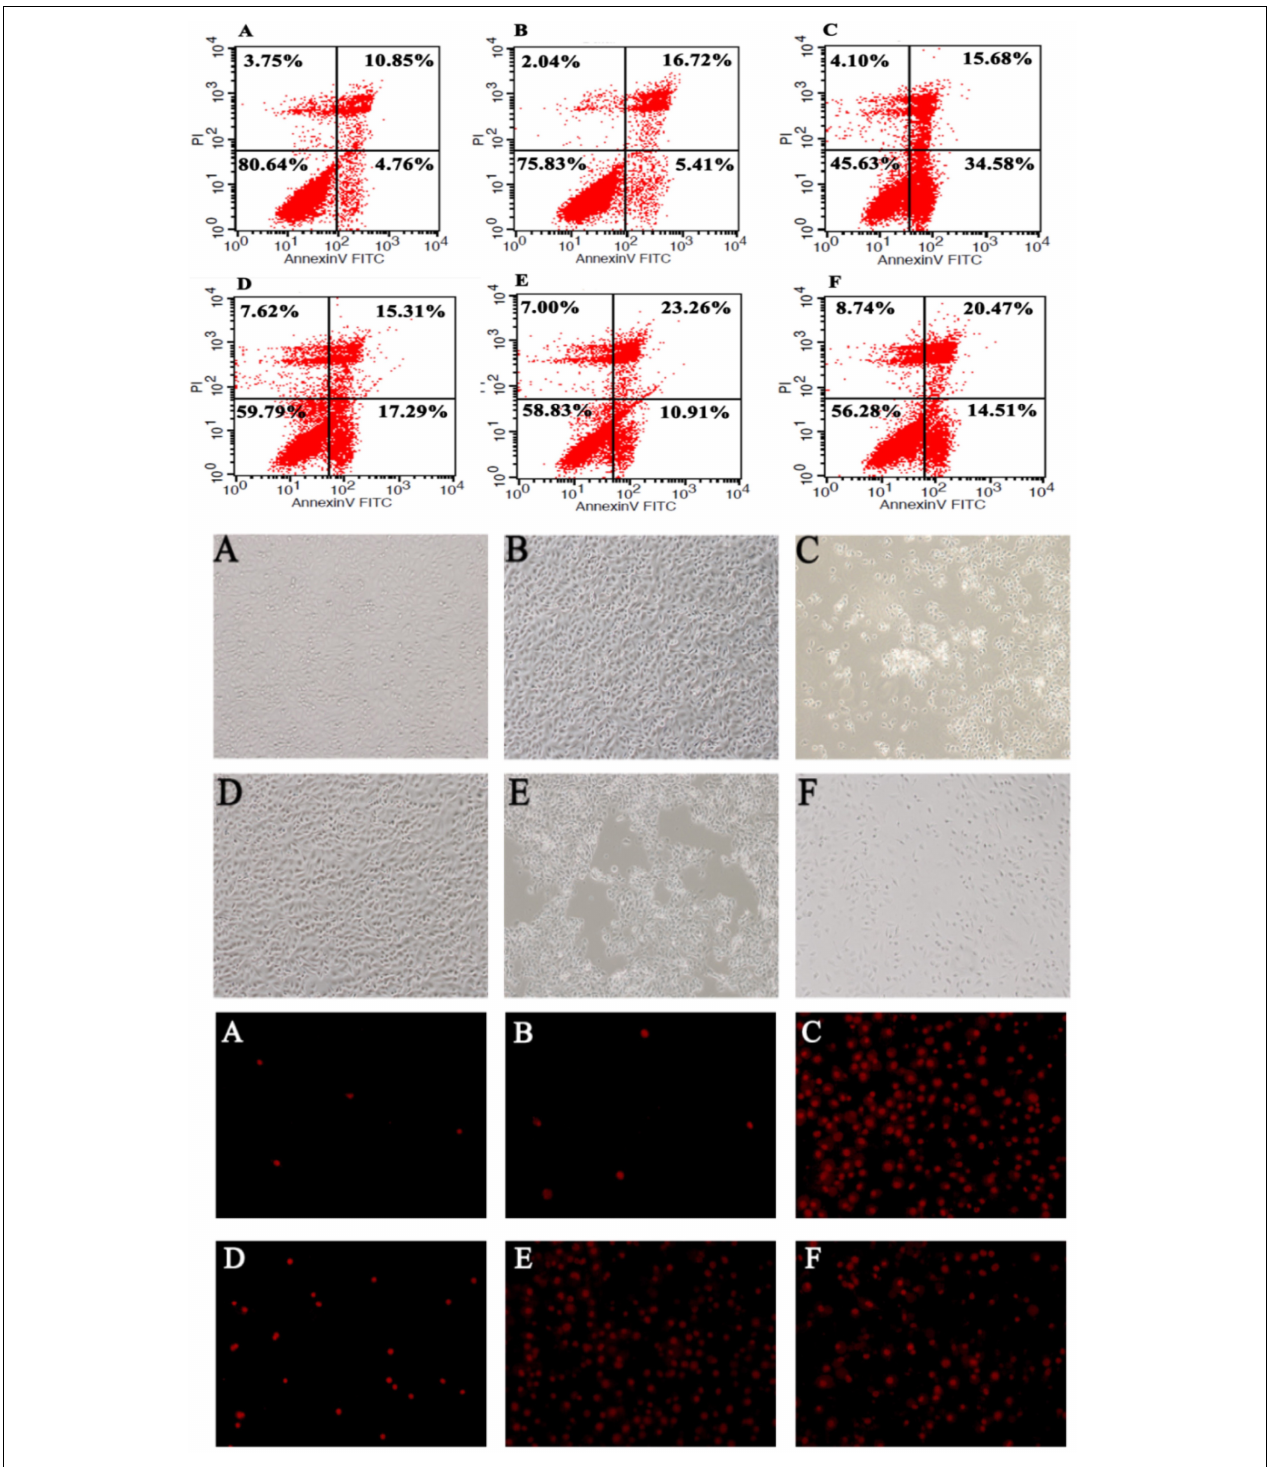
FIGURE 6 | Bacteroides fragilis ZY-312 inhibits colon cell apoptosis induced by C. difficile . Flow cytometry analyses (top) of HT-29 cells in all groups are shown. The lower right quadrant represents colon cells in early apoptosis. Microscopic observations (middle) of IEC-6 cell morphology and viability and PI staining (bottom) of IEC-6 cells in all groups are shown. (A) Blank control group, 5 × 10 5 HT-29 or IEC-6 cells were cultured without treatment. (B) B. fragilis group, cells were incubated with 5 × 10 8 cfu B. fragilis . (C) C. difficile group, cells were incubated with 5 × 10 7 cfu C. difficile . (D) Exclusion group, cells were infected with 5 × 10 8 cfu B. fragilis for the first hour and 5 × 10 7 cfu C. difficile for the second hour. (E) Competition group, cells were co-infected with B. fragilis and C. difficile . (F) Substitution group, cells were infected with C. difficile for the first hour and B. fragilis for the second hour. The cells were incubated at 37 ◦ C under anaerobic conditions for 2 h.